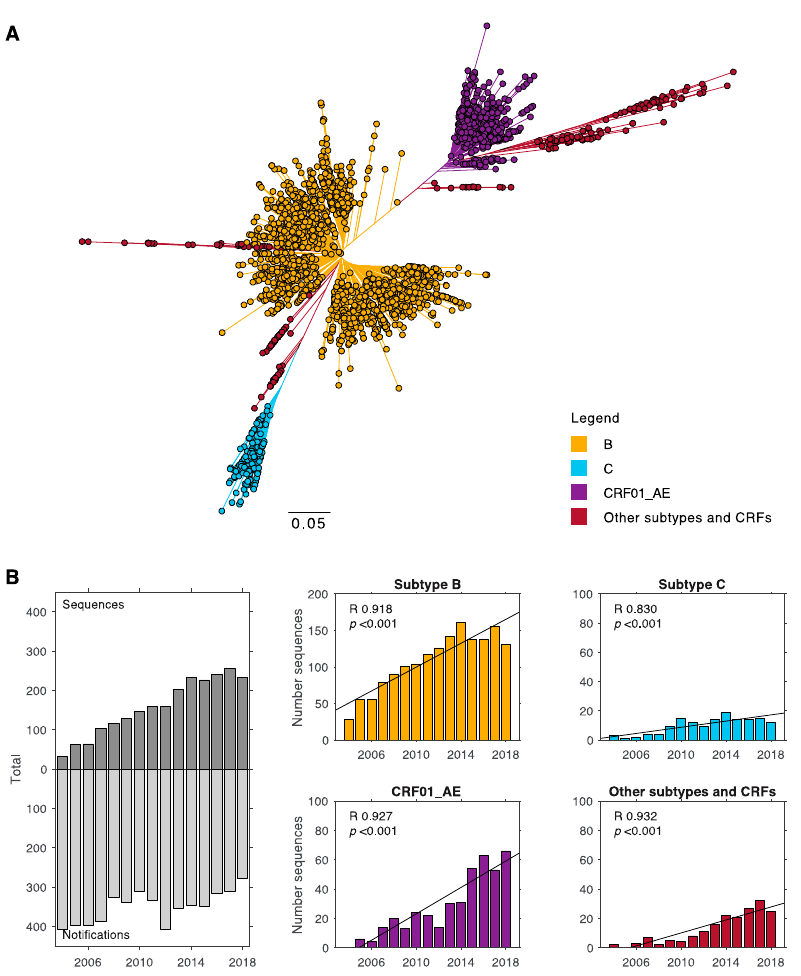
Figure 1. HIV-1 subtype diversity in New South Wales (NSW) for the past 14 years. ( A ) Maximum likelihood tree for HIV-1 sequences in NSW. Reverse transcriptase sequences sampled between 2004 and 2018 were used to estimate a tree phylogeny. Branch length indicates nucleotide substitutions per site. ( B ) Left panel: Number of sequences used in this analysis compared to the number of new HIV-1 infections notified in NSW. Other panels: number of sequences for di ff erent subtypes across time and linear regression with correlation coe ffi cient (R) and p values indicated. Yellow = subtype B, cyan = subtype C, purple = CRF01_AE, and red = other subtypes and CRFs (including